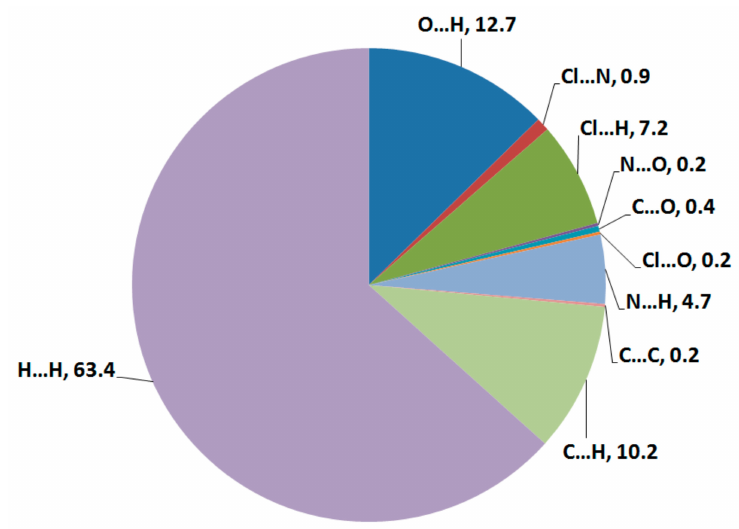
Figure 4. The intermolecular contacts in 4 and their percentages.